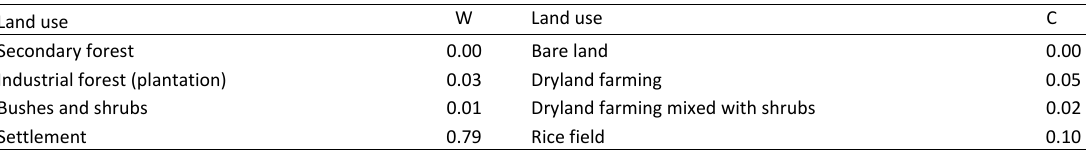
Table 3: Weight (W) for land use types